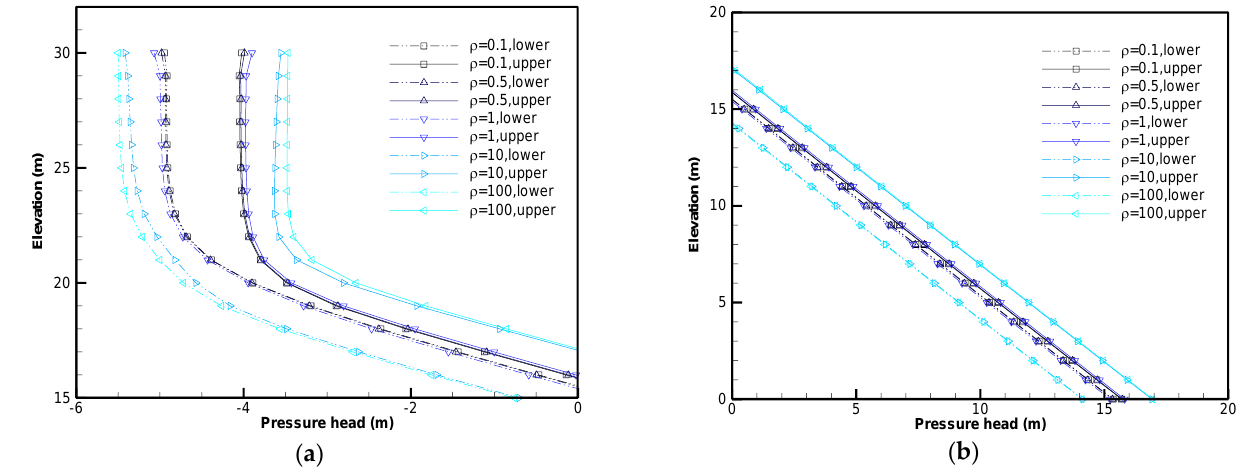
Figure 5. Bounds of pressure head along section 1-1′: ( a ) above the phreatic surface; ( b ) below the phreatic surface.